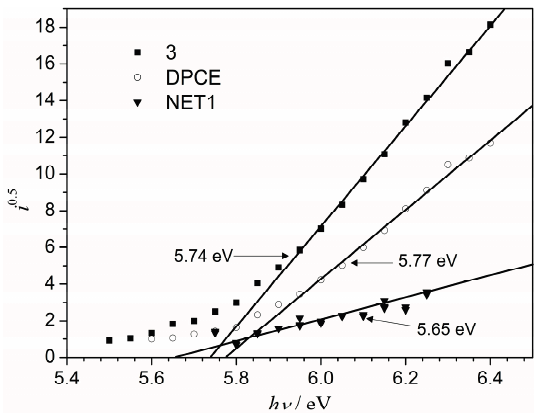
Figure 5. Photoemission spectra of the films of 3 and DPEC .